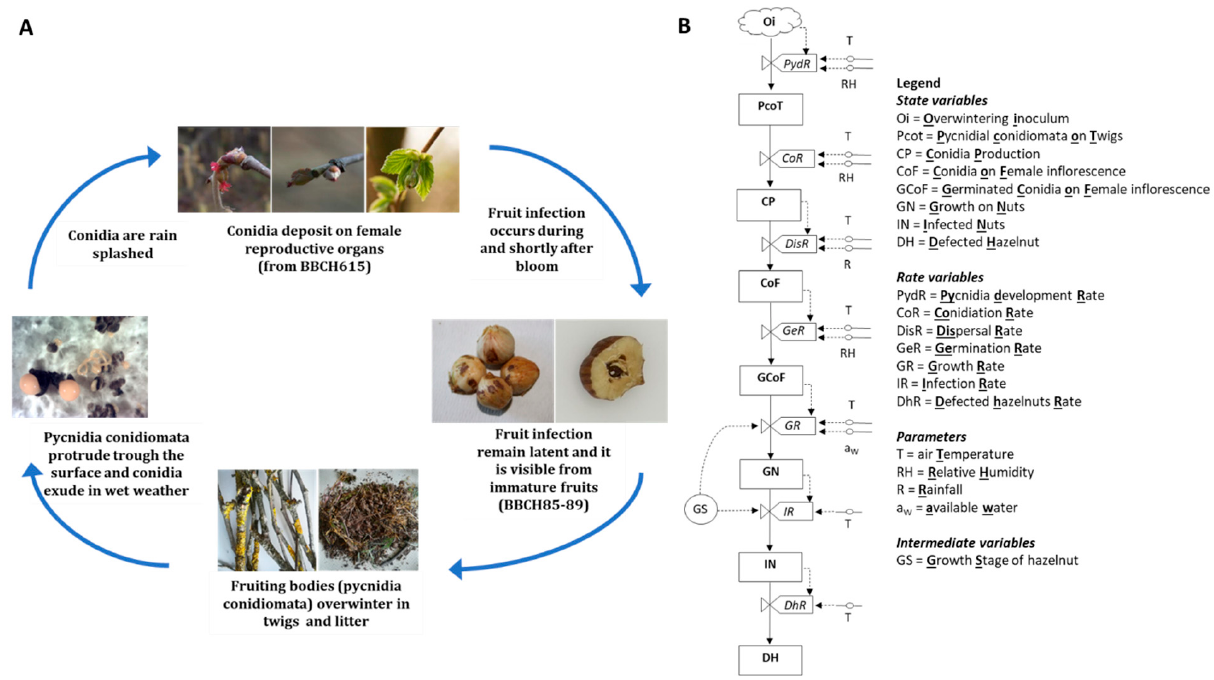
Figure 1. ( A ) Simplified description of Diaporthe eres infection cycle on hazelnut, and ( B ) relation diagram. Boxes are state variables; solid arrows represent fluxes and directions of states; dotted arrows represent fluxes and directions of variables (data input); circles symbolise intermediate variables; “bow ties” are valves in fluxes (rates) (we report the acronym explanations directly in the